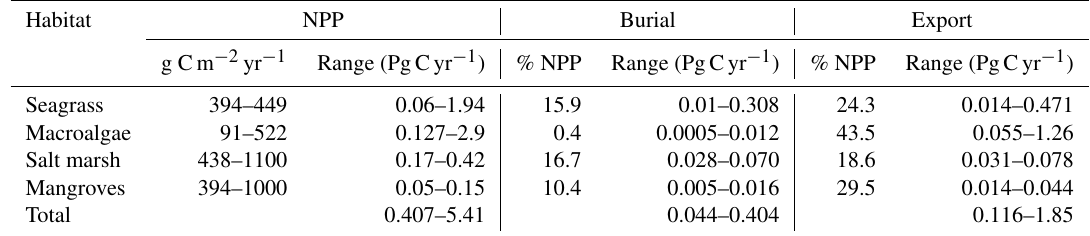
Table 2. Net primary production (NPP), carbon burial and export production of vegetated coastal habitats. Lower range of areal production values from Duarte and Chiscano (1999) and upper range of areal seagrass production calculated from gross community production in Gatuso et al. (1998), assuming community respiration ( R ) R = 0.5 GPP from Duarte and Cebrián (1996). Upper value for areal mangrove and salt- marsh production calculated as the ratio between global NPP and global area in Duarte and Cebrián (1996). Range of global macroalgal production from Krause-Jensen and Duarte (2016). Percent NPP buried and exported for various habitats from Duarte and Cebrian (1996), and global burial and export ranges calculated by combining these percent values with the range of global NPP values. Habitat NPP Burial Export g Cm − 2 yr − 1 Range (PgCyr − 1 ) % NPP Range (PgCyr − 1 ) % NPP Range (PgCyr − 1 )